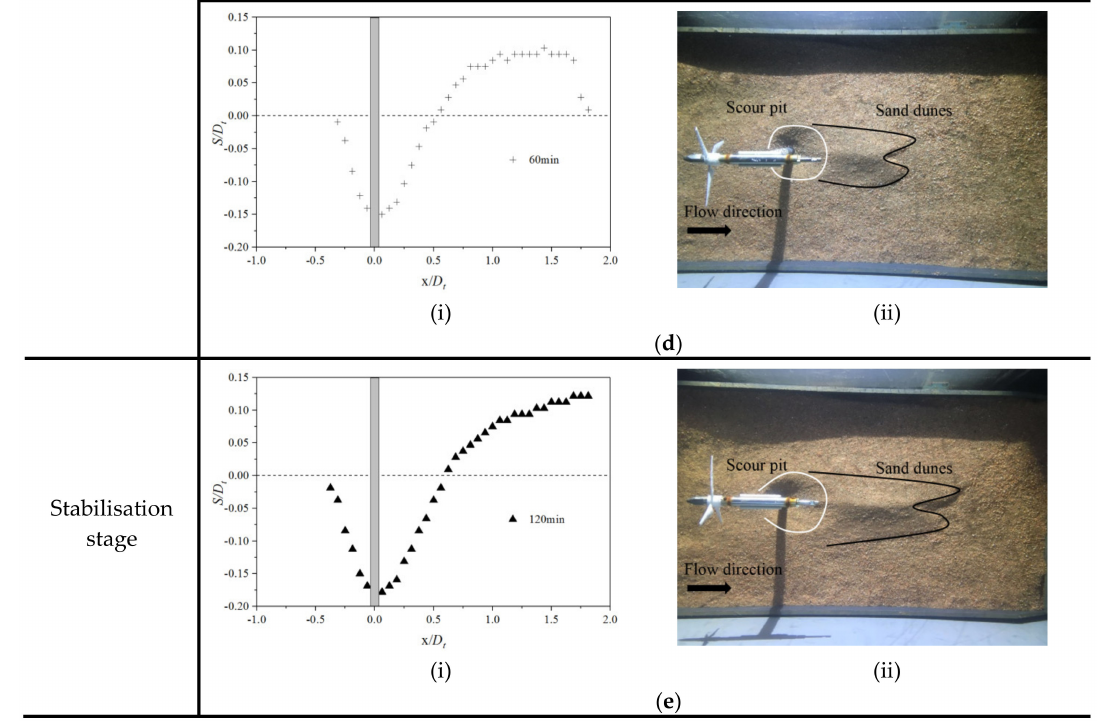
Figure 13. Scour patterns with the scouring process with times: ( a ) Time = 2 min. ( b ) Time = 15 min. ( c ) Time = 30 min. ( d ) Time = 60 min. ( e ) Time = 120